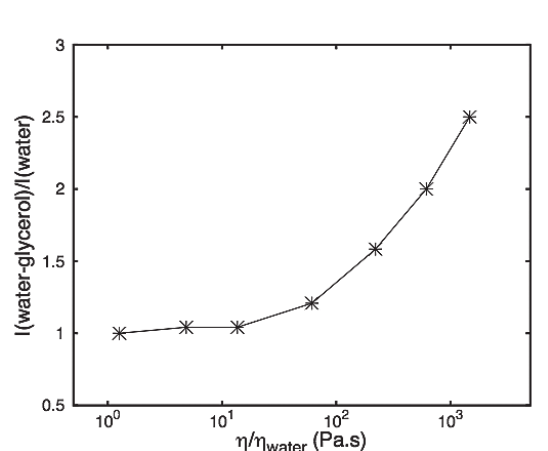
Fig. 9 Intensity consumption at funicular state for wa- ter-glycerol, scaled by the intensity using water, versus the corresponding scaled viscosity for 100 µm glass